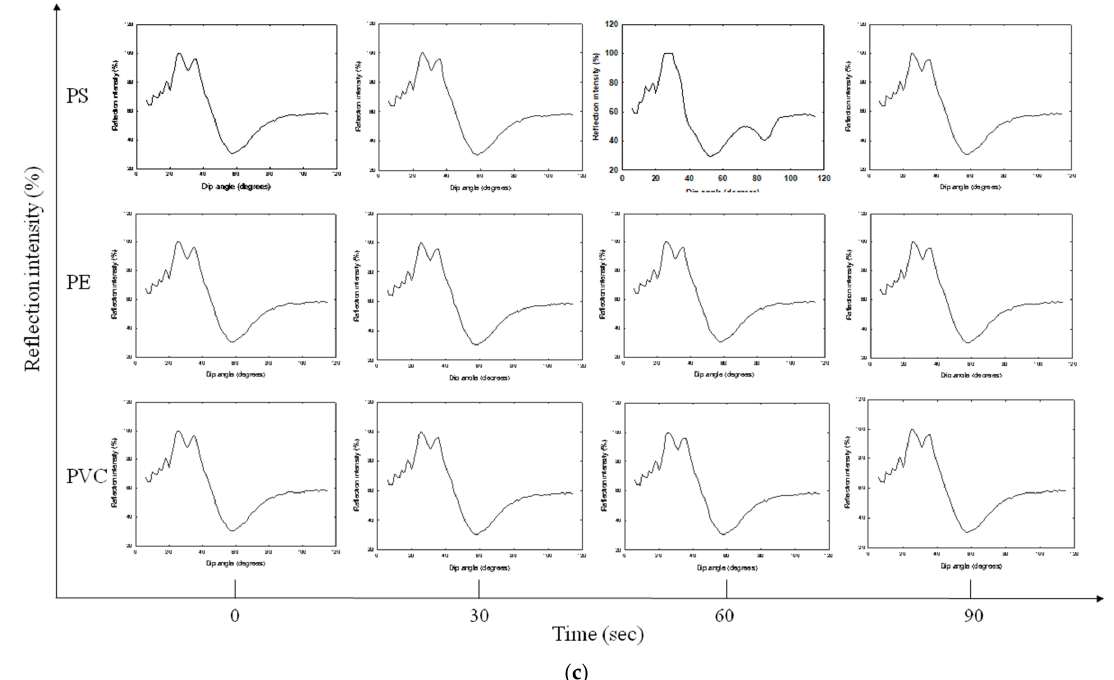
Figure 4. Refraction angle changes of microfluidic in SPR. ( a ) Schematic diagram of micro-plastics’ movement in microfluidic; PS, PE and PVC reacted without ( b ) or with ( c ) ERs resulting in a refraction angle change were recorded.